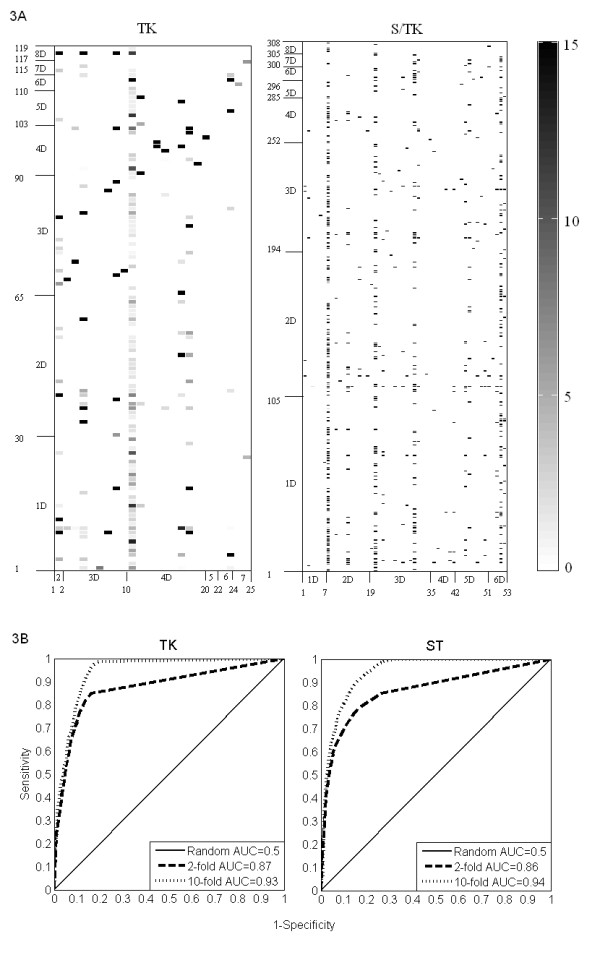
Heat maps of the domain signature pairs associated with kinase-substrate interactions & ROC curves in cross-validation. Pairs of strings of domains (one on a kinase, the other on its substrate) that are statistically enriched (p < 0.001) in phosphorylation binding interactions in the learning set compared to the set of random pairs of proteins made up of proteins in the same set. The horizontal and vertical axes refer to indices of strings of domains enriched in kinases and kinase substrates, respectively. The scale - log p indicates the level of enrichment of the signature pairs shown in the figure 3A. The receiver operating characteristics (ROC) curves for 2-folds and 10-folds cross-validation (3B). The area under the ROC curves (AUC) is also shown for the ROC curves in the figure.